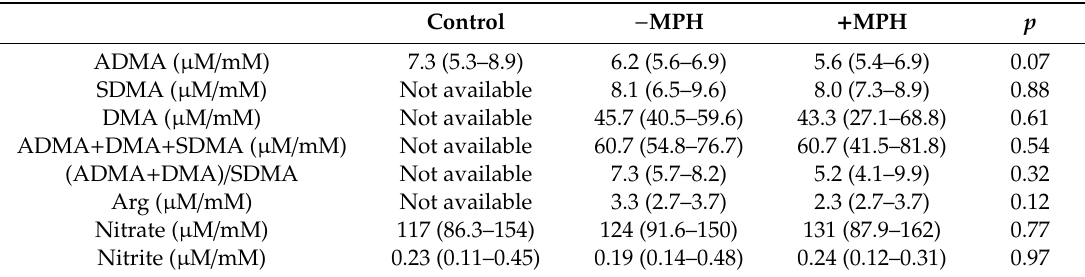
Table 2. Creatinine-corrected urinary concentrations of ADMA, symmetric dimethylarginine (SDMA), dimethylamine (DMA), arginine (Arg), nitrate, and nitrite of controls and ADHD children without ( − MPH) and with ( + MPH) methylphenidate (MPH) medication.